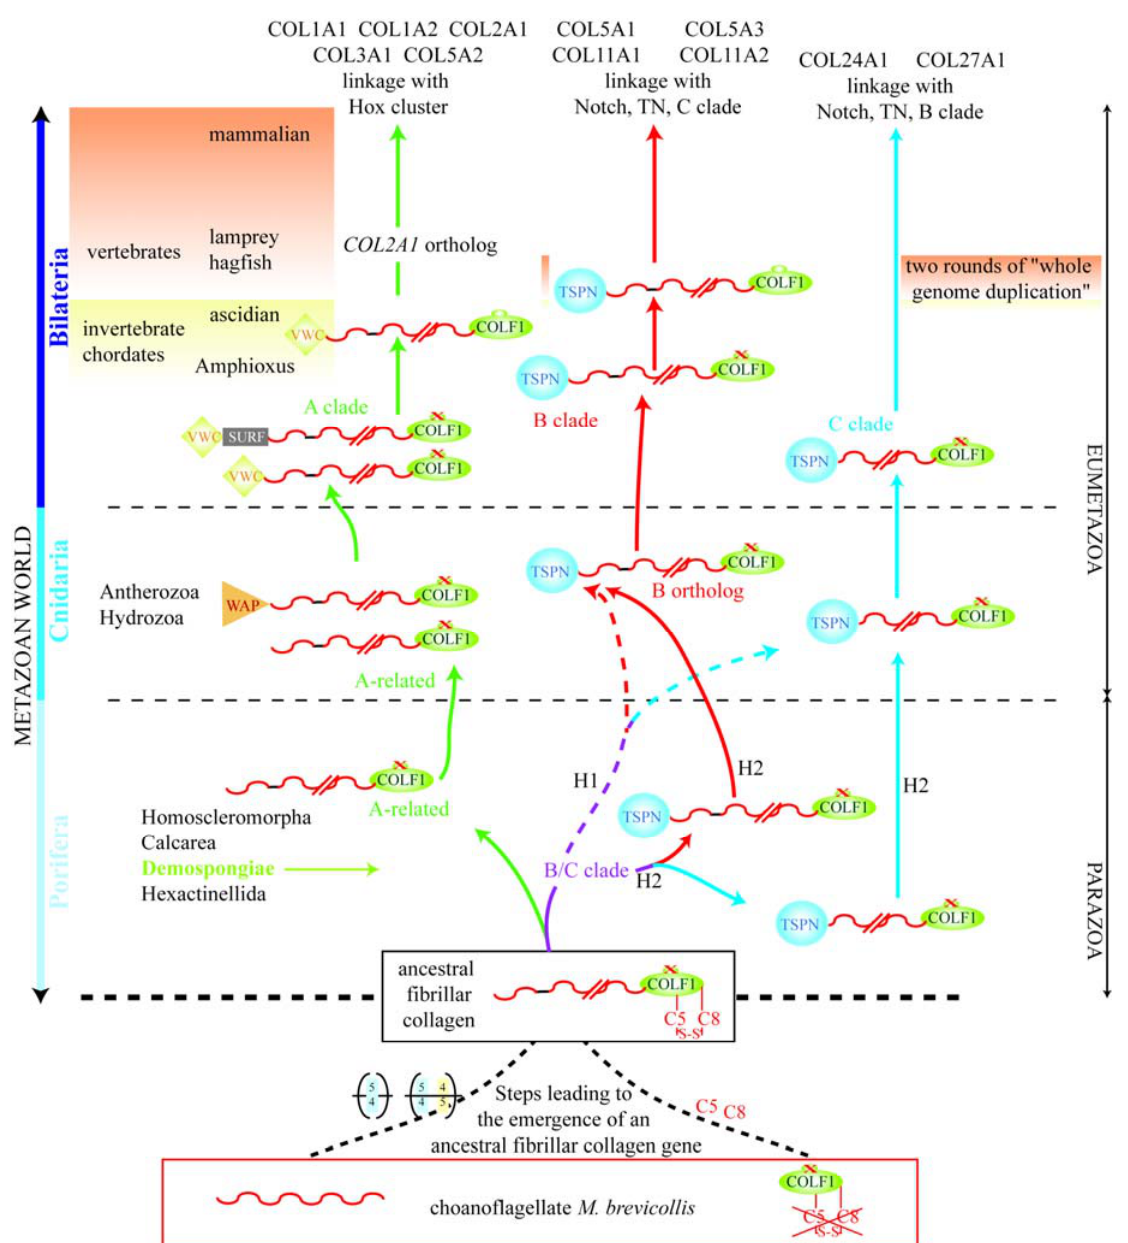
Figure 6. Evolution of the fibrillar collagen family. This model was modified from a previous study [30]. It should be followed from the bottom to the top. In this model, we suggest that the steps leading to the formation of an ancestral  chain occurred before the metazoan radiation and the divergence of the three clades predated the Parazoa-Eumetazoa split. The different steps (emergence of the different clades, module or chain selection sequence acquisition) are presented. We have two major hypotheses concerning the B/C clades. In the H1 scenario, sponges possess fibrillar collagen chains containing a TSPN module and the related genes have duplicated before the divergence of the B and the C clades from an ancestral B/C clade gene. In this hypothesis, the emergence of the B and C clades occurred between Parazoa-Eumetazoa and Cnidaria-Bilateria split. In hypothesis H2, B and C clade genes are present in demosponges and their emergence predated metazoan